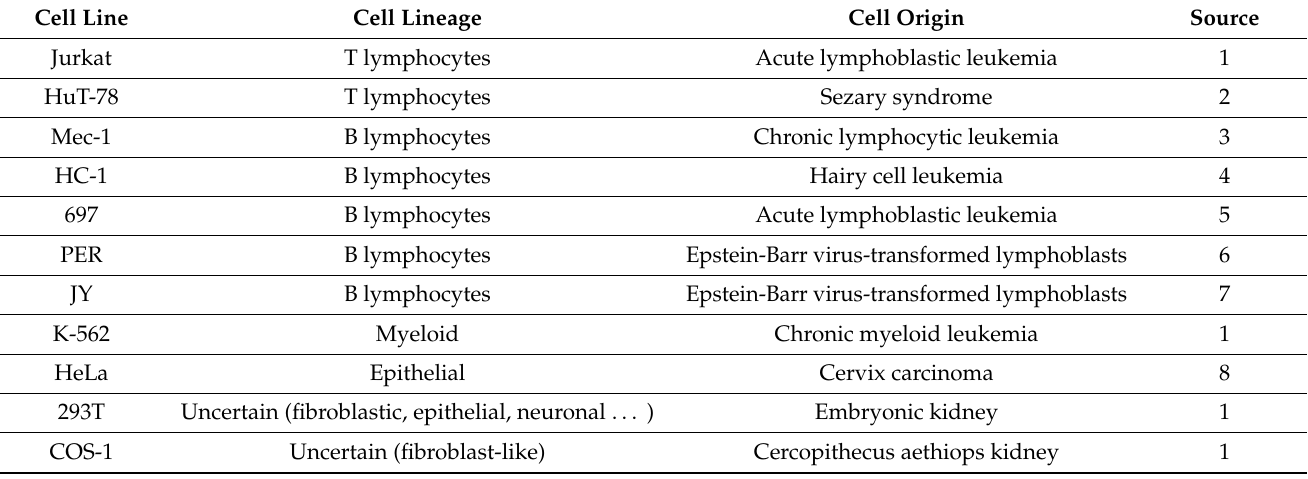
Table 1. Cell lines used in this